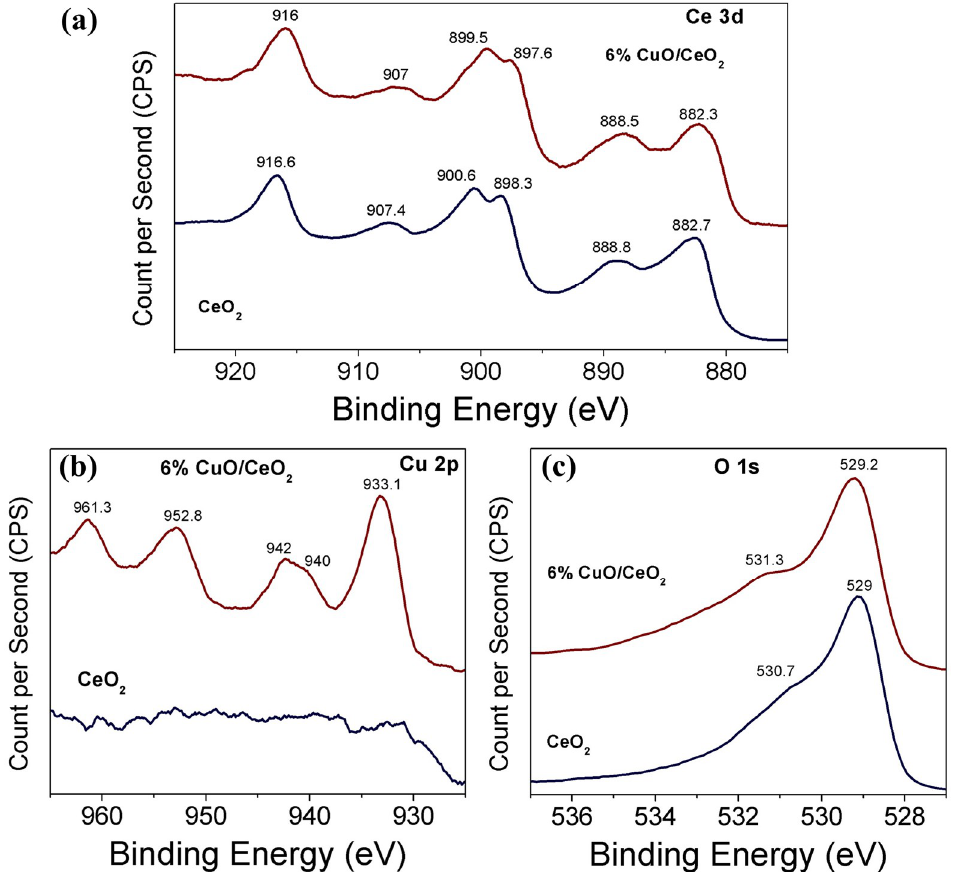
Figure 5. XPS high-resolution spectra of ( a ) Ce 3d, ( b ) Cu 2p and ( c ) O 1s of CeO 2 and 6% CuO-CeO 2 catalysts, synthesized using the solution combustion method.